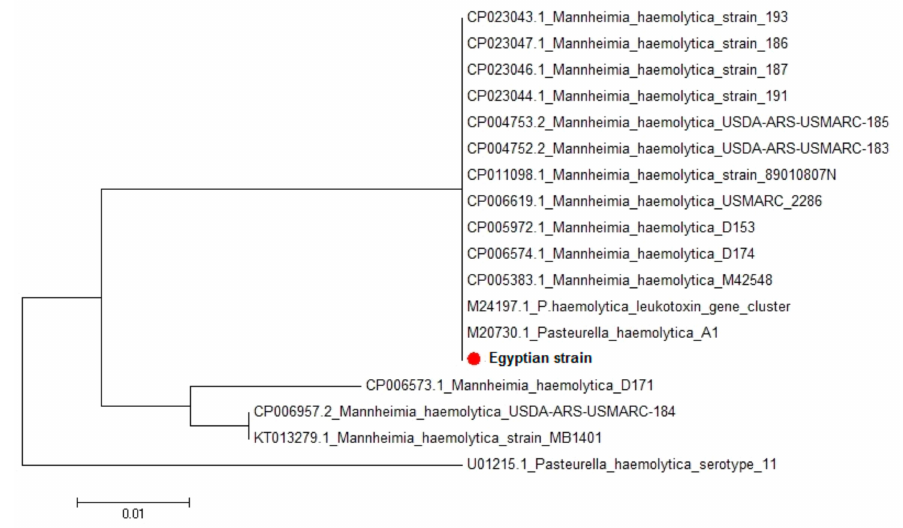
Figure 2. Phylogenetic tree for M. haemolytica A2 lkt C partial sequences showing clear clustering of the Egyptian strain with di ff erent strains uploaded in the